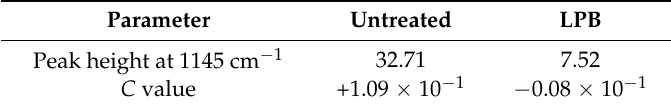
Table 2. Characteristic, analytical parameters for the reference specimens.